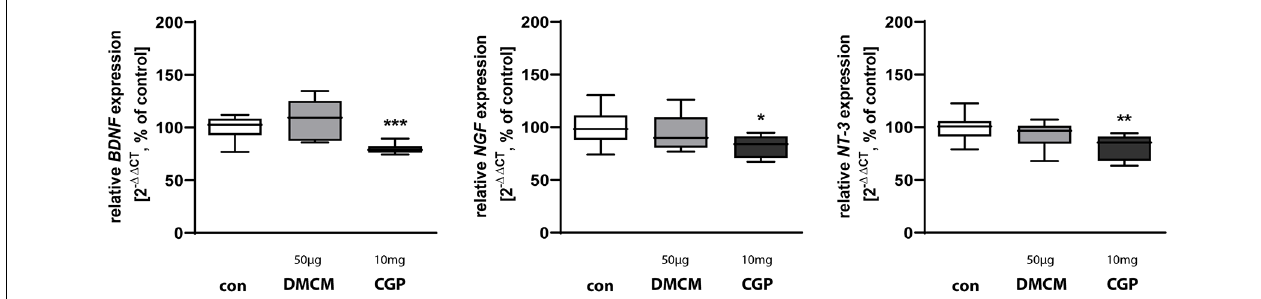
FIGURE 4 | Expression of neurotrophins BDNF , NGF , and NT-3 is reduced in CGP treated animals. The relative mRNA expression of markers was measured by quantitative real-time PCR in rat brain homogenates with DMCM 50 µ g/kg (gray bars) or CGP 10 mg/kg (black bars) application relative to control (white bars). Bars represent the relative mRNA quantification based on internal standard HPRT . Data shown as mean ± SEM, n = 9–10. * p < 0.05, ** p < 0.01, and ∗∗∗ p < 0.001 vs. control (Brown-Forsythe test for BDNF , one-way ANOVA for NGF and NT-3